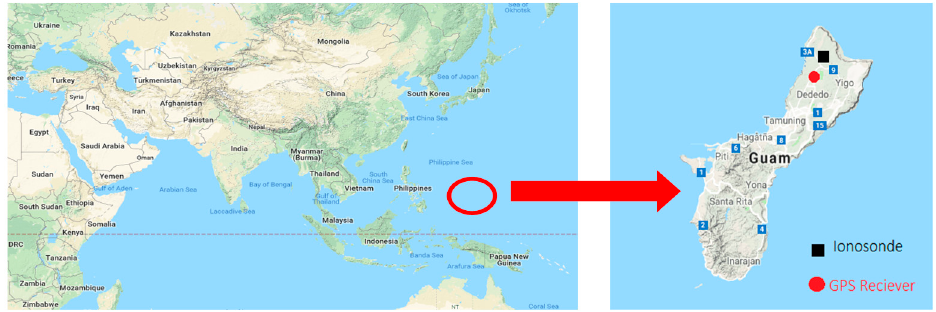
Figure 1. Location of the two stations with ionosonde and GNSS receivers: Guam near the equatorial ionization anomaly (EIA).